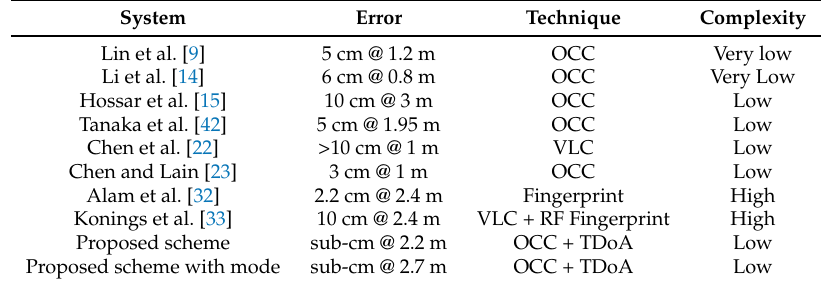
Table 3. Performance comparison between the proposed system and other works available in the literature. System Error Technique Complexity Lin et al. [9]